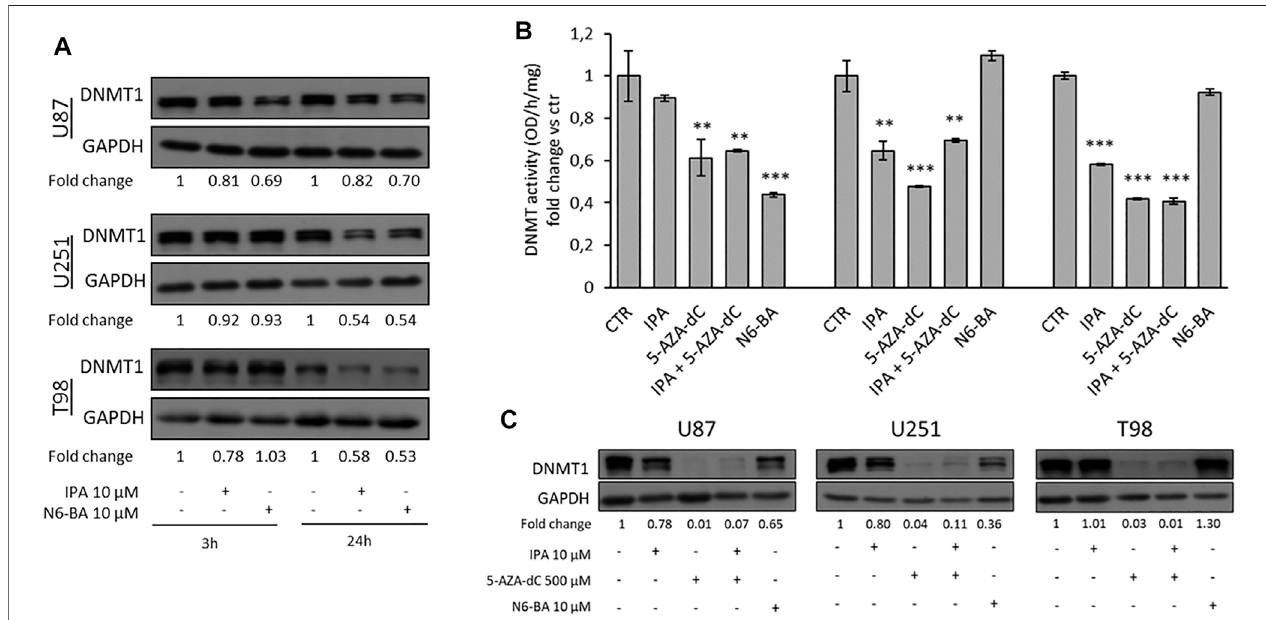
FIGURE 5 | IPA and N6-BA affect DNMT expression and activity. (A) Representative western blot and relative densitometric analysis (fold change vs. control) of DNMT1expressioninU87,U251,andT98cellstreatedwithIPAorN6-BA.GAPDHwasusedasaloadingcontrol. (B) ColorimetricDNMTactivityassayperformedusing nuclear extracts from GBM cells treated for 24 h with IPA (10 µM), 5-AZA-dC (500 µM), IPA+5-AZA-dC combination, or N6-BA (10 µM). DNMT activity (OD/h/mg) is expressedasfoldchangevs.control.Dataareexpressedasthemean±SDofsixindependentexperiments.** p < 0.01;*** p < 0.005vs.control. (C) Representative westernblotandrelativedensitometricanalysis(foldchangevs.control)ofDNMT1expressioninextractsoptimizedtopreservetheenzymaticactivityofGBMtreatedfor 24 h as indicated. GAPDH was used as a loading control.